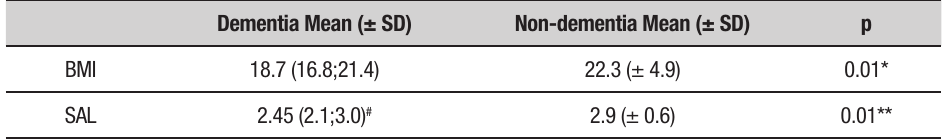
Table 3. Comparison of “dementia” and “non-dementia” groups for body mass index and serum albumin level.